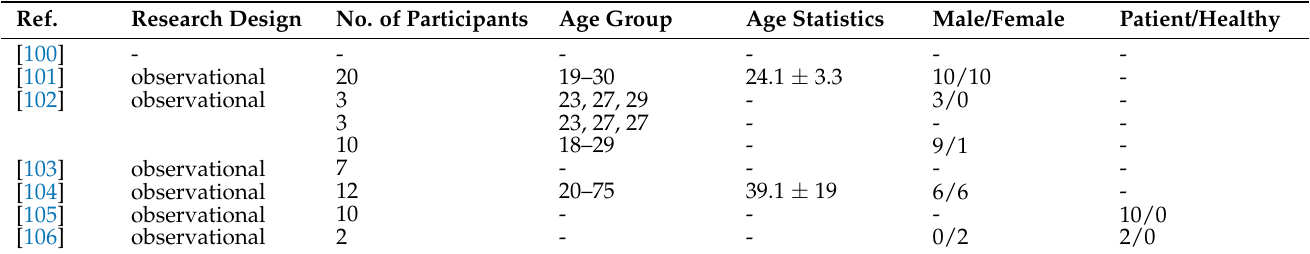
Table 11. Participant demographics for the additional conducted user studies. - = no information.